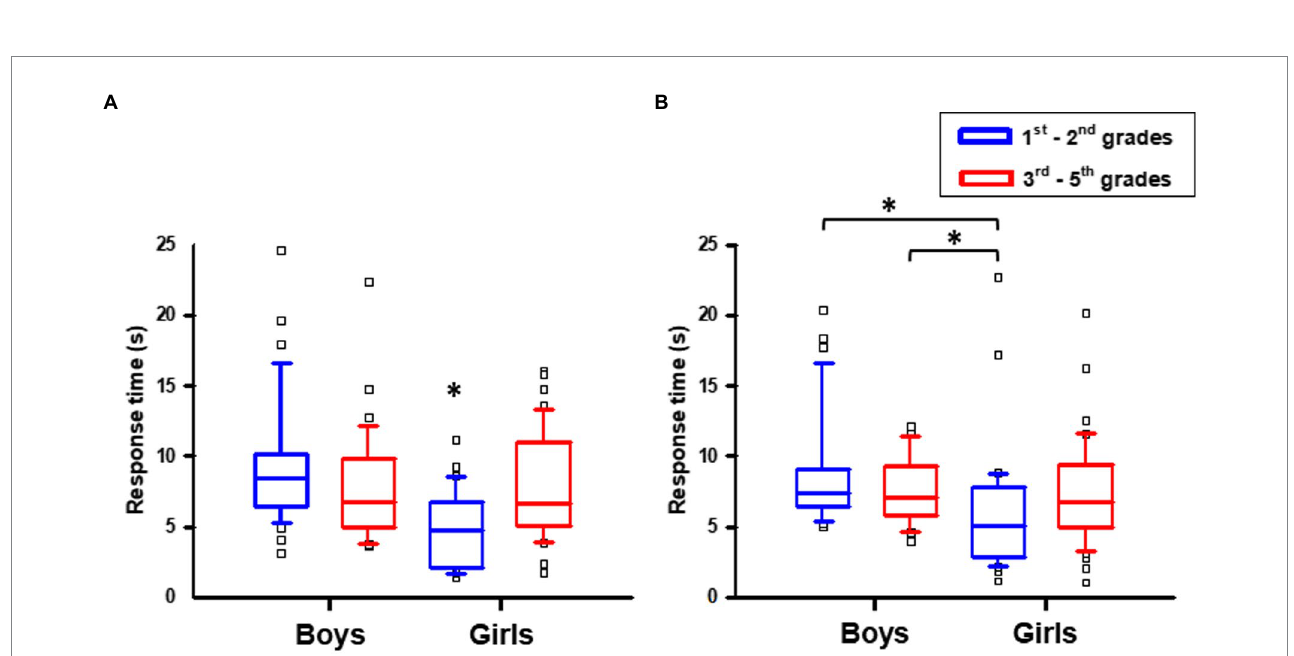
FIGURE 3 Response time by age and sex: (A) letter rotation test, (B) mirrored letter